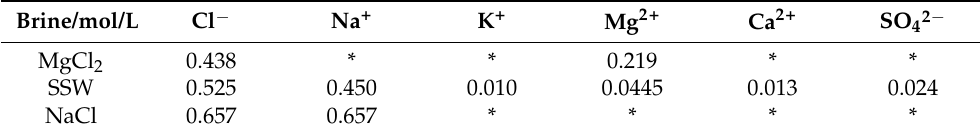
Table 1. Ion concentration of the brine used in the experiment. * The ion is not present in the brine. Brine/mol/L Cl − Na + K + Mg 2+ Ca 2+ SO 42 − MgCl 2 0.438